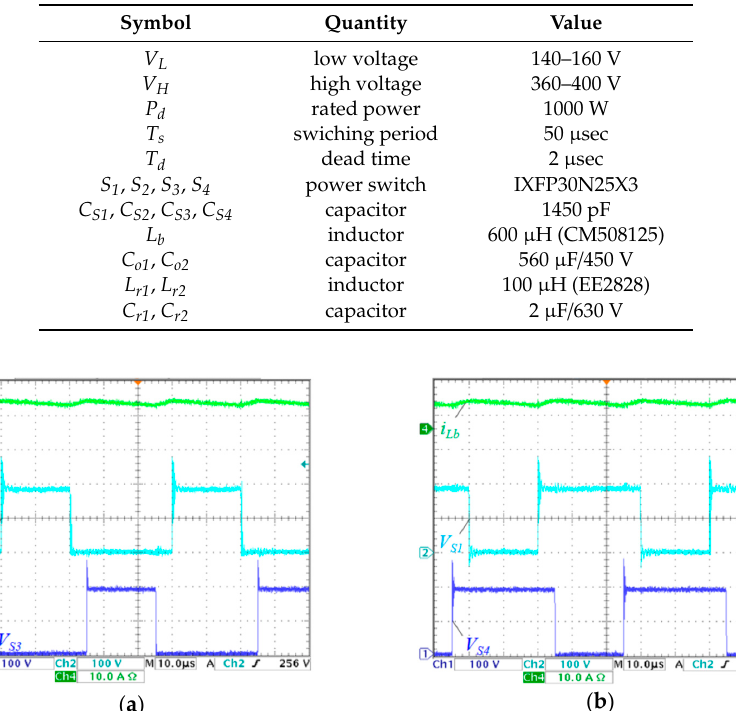
Table 1. Electrical specifications and circuit parameters.